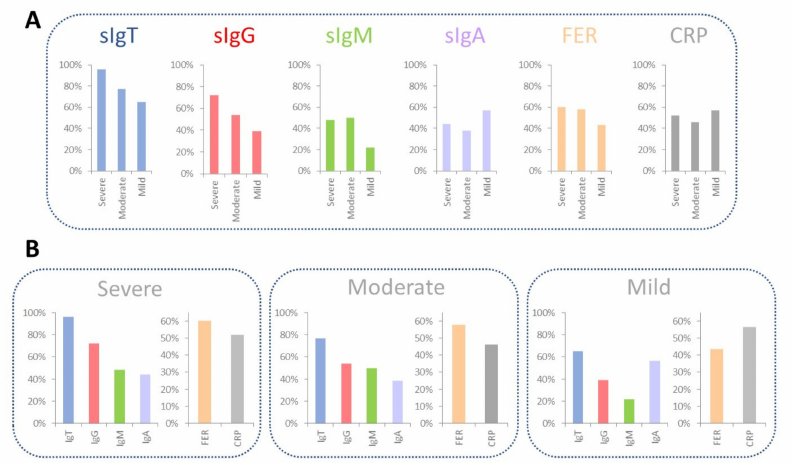
Figure 6. Summary of the qualitative comparison. ( A ) Percentage of positives for each biomarker as a function of the LSC. ( B ) Classification of each LSC as a function of the titers of sIgT, sIgG, sIgM, sIgA, FER, and CRP. Abbreviations: Level of Severity of COVID-19 (LSC), total specific Immunoglobulins (sIgT), specific Immunoglobulins G (sIgG), specific Immunoglobulins M (sIgM), specific Immunoglobulins A (sIgA), together with Ferritin (FER), C Reactive Protein (CRP) and ∆ IROP (%) (Increased Relative Optical Power.